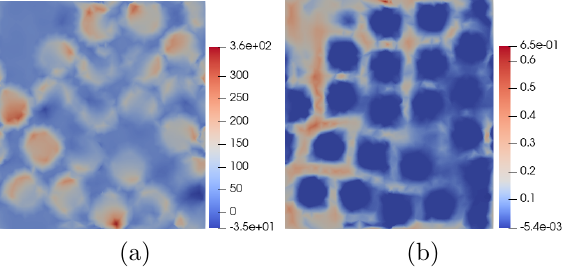
Figure 17. Carbon composite with minimal stiffness, time = 100 s: a) Shear stress [MPa], b) creep